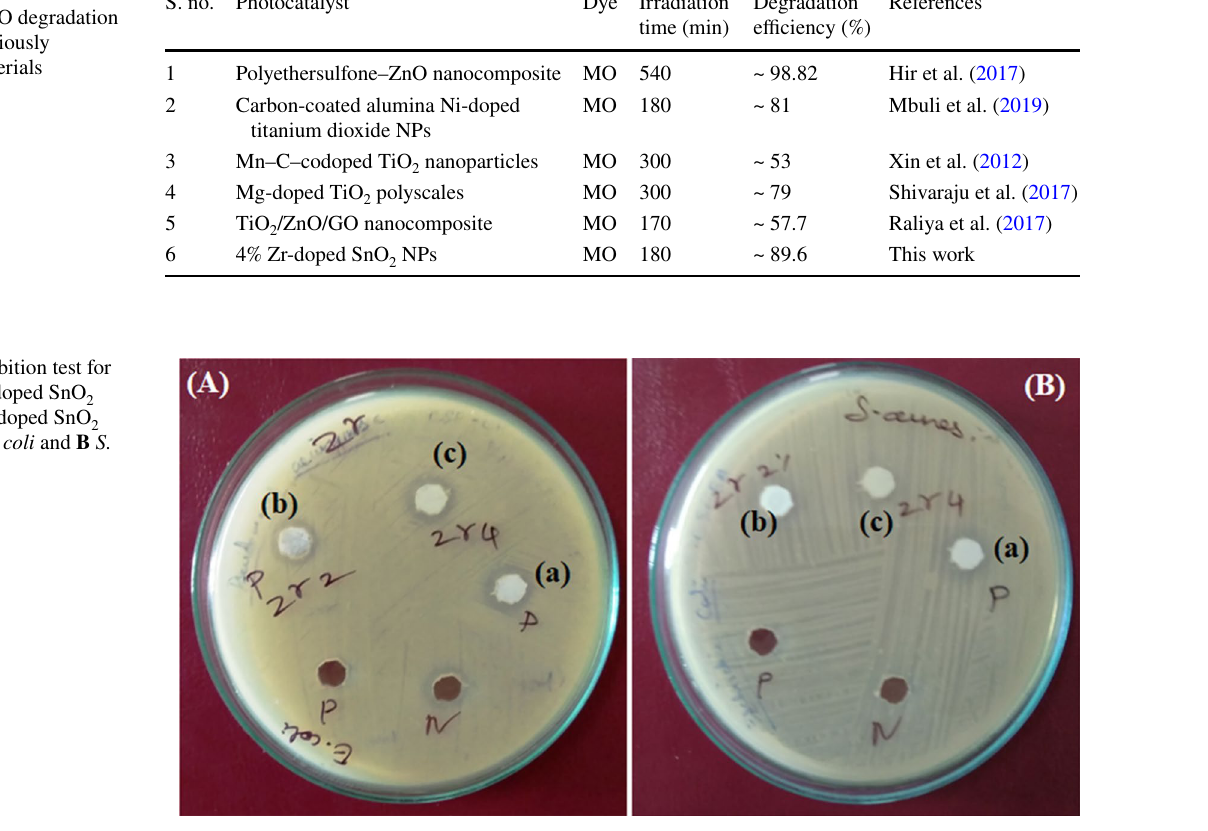
Table 1 Comparison of visible- light generated MO degradation rate (%) over previously reported nanomaterials